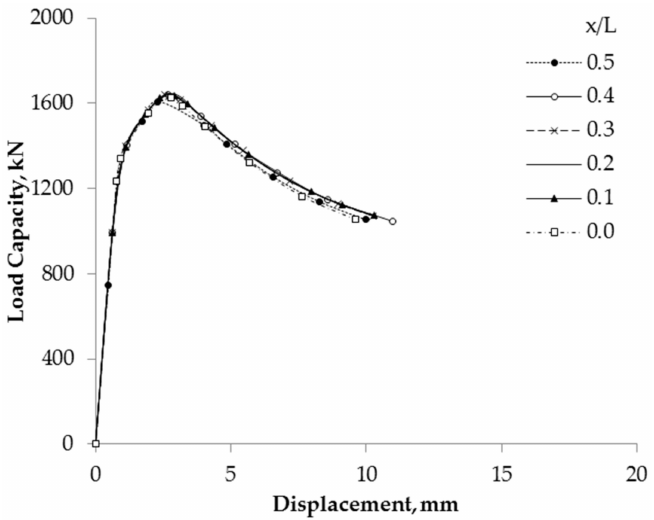
Figure 12. Compressive behavior of specimen D4H60-C360B depending on di ff erent